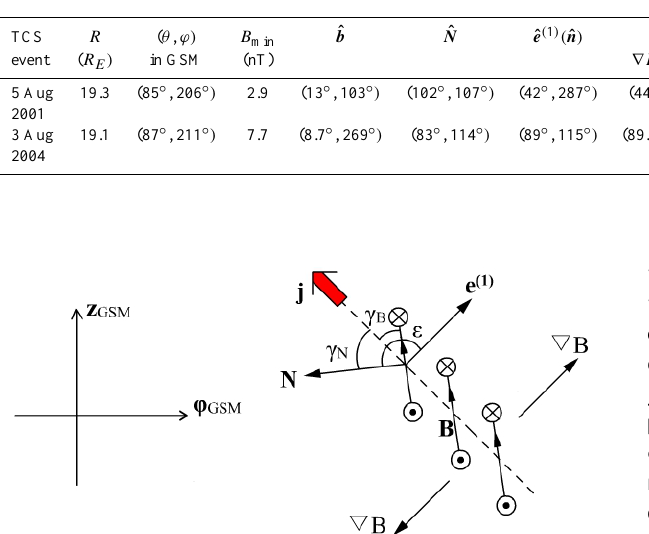
density contributes a significant part of the total current den-